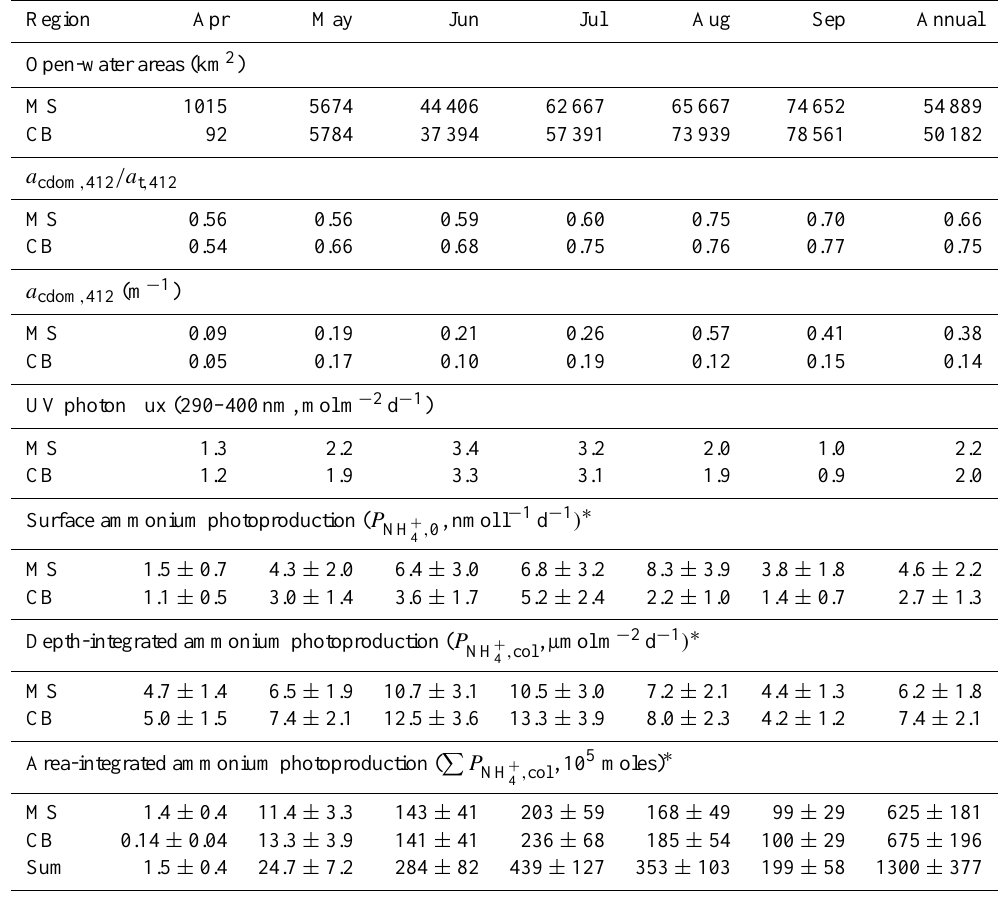
Table 3. Modeled monthly ammonium photoproduction rates in open waters of the SE Beaufort Sea in 2009, along with open-water areas, ocean color-derived a cdom , 412 : a t , 412 ratios and a cdom , 412 , and downwelling UV photon fluxes. Open-water areas excluded those where no ocean-color data were available. Lack of ocean color data also left out October and November. December to March were omitted due to nearly complete ice cover. MS stands for Mackenzie Shelf and CB for Canada